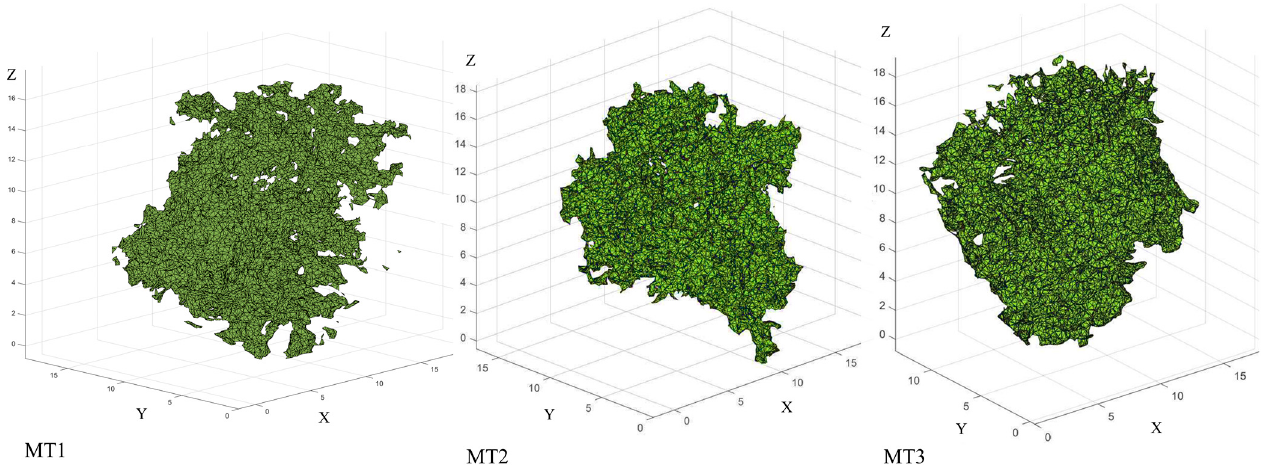
Figure 9. The three crown meshes reconstructed with the alpha shape ( α : 0.25) algorithm.